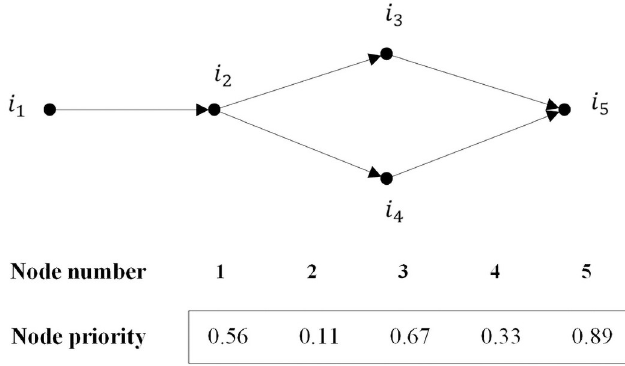
Fig 12. The chromosome representation of the bottom-level